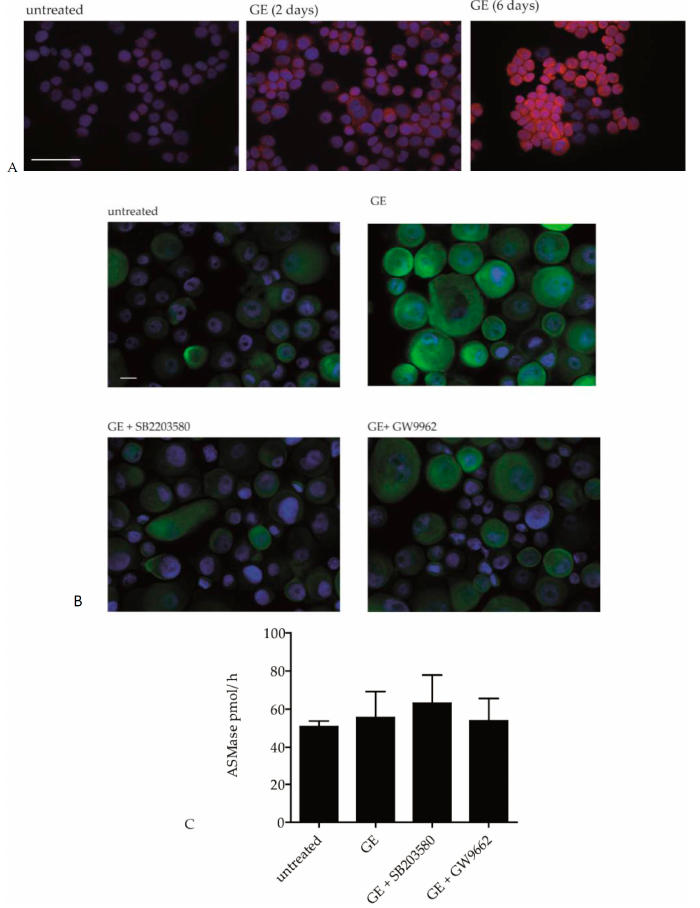
Figure 5. GE induces CerS3 expression but not sphingomyelinase activity. ( A ) hPKs were treated with GE (200 µg/mL) for 0, 2, or 6 days. Then, the cells were stained against CerS3. The pictures were photographed at magnification of 100×, and the bar indicates 50 µm; ( B ) hPKs were treated with GE (200 µg/mL), or with GE and one of the inhibitors (PPAR γ antagonist GW9962 or p38 MAPK inhibitor SB203580) for 6 days. Then, the cells were stained against CerS3. The pictures were photographed at a magnification of 400×, and the bar indicates 10 µm; ( C ) hPKs were treated with GE (200 µg/mL) or with GE and inhibitors, as indicated, for 6 days. Then, the sphingomyelinase activity was measured in the cell lysates. Data are expressed as means ± SD of three independent experiments (ns—not significant).